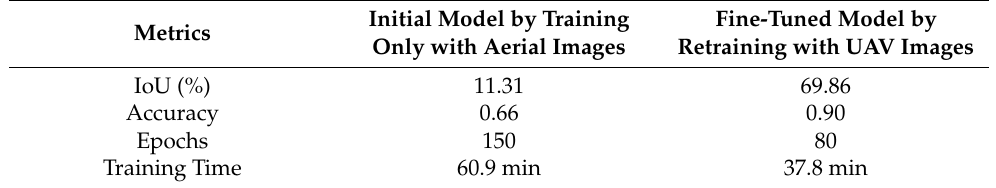
Table 4. Results of the pre-trained model from aerial images of Inria dataset and the fined-tuned model from UAV test data in Kandy, Sri Lanka.